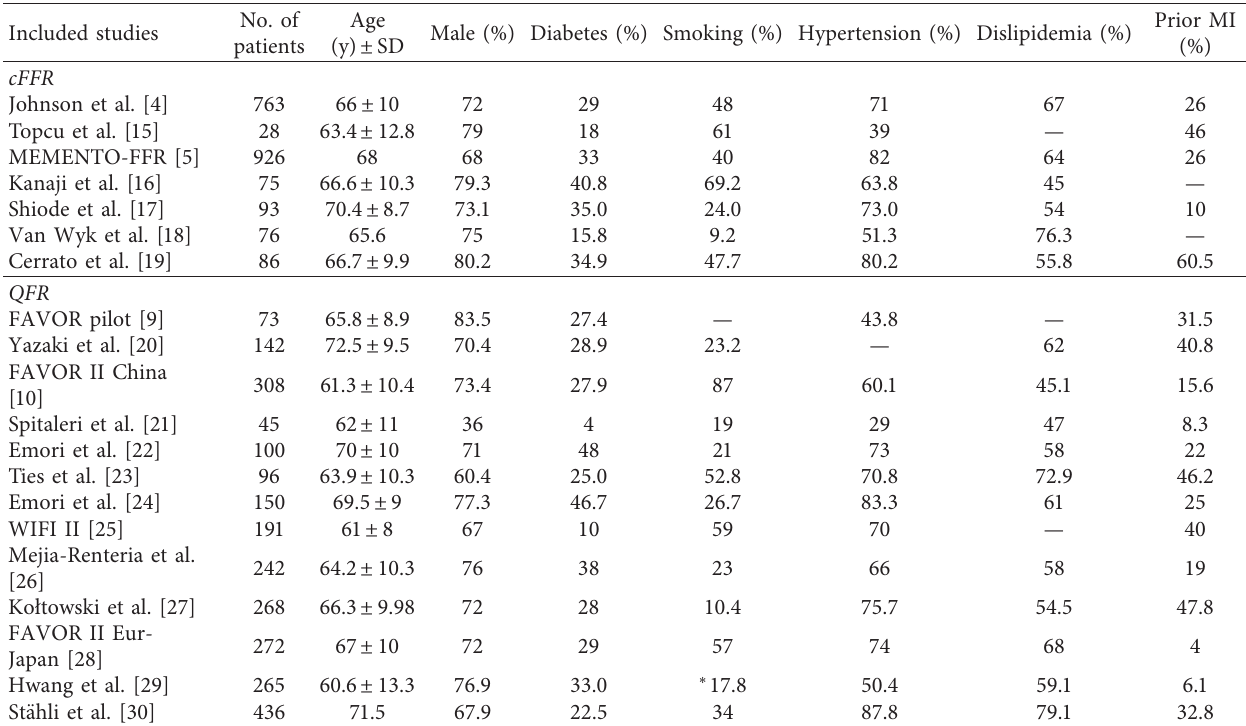
Table 2: Baseline patient characteristics.